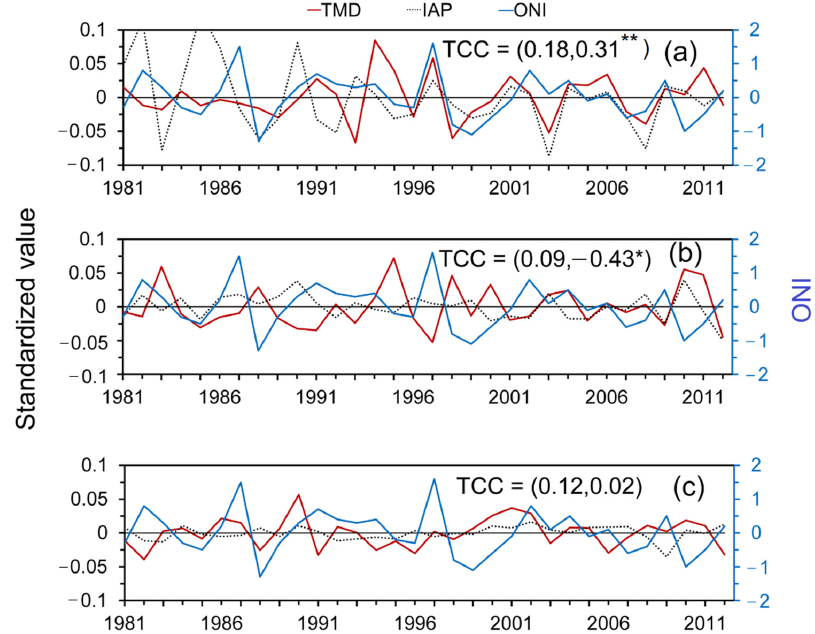
Figure 6. PC time series for the first three dominant modes of observed (solid red line) and IAP- AGCM simulated (Dotted black line) summer rainfall over Thailand during 1981–2012 for ( a ) EOF-1, ( b ) EOF-2, and ( c ) EOF-3, together with the ONI value (solid blue line). The first TCC value in parenthesis indicates the correlation coefficient between TMD and IAP, while the second value is for the coefficient between TMD and ONI. A single asterisk (*) indicates significance at p < 0.05, while double asterisks (**) is for significance at p < 0.10.